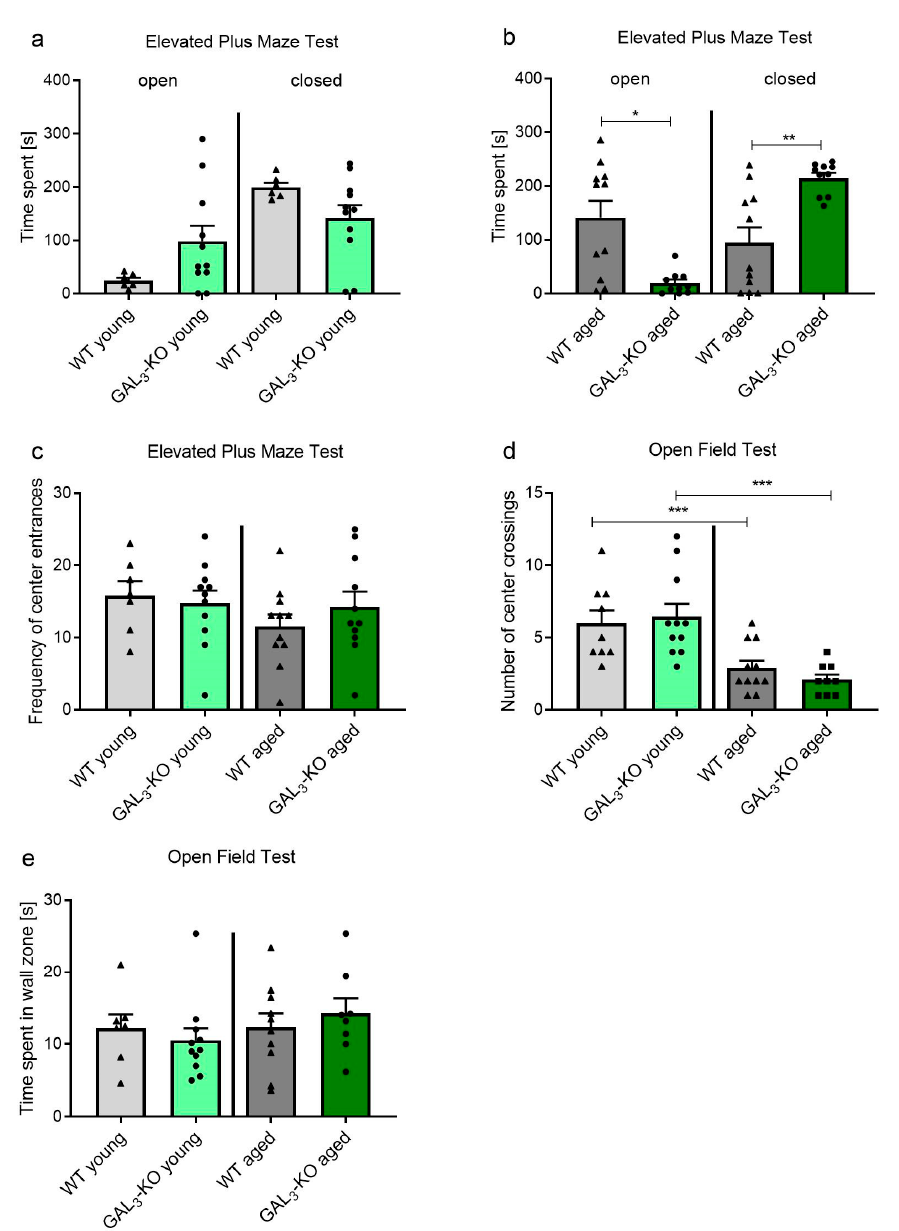
Figure 1. Behavior of GAL 3 -KOand WT mice in ( a – c ) EPM and ( d , e ) OF tests. Time spent in the open and closed arms of the EPM in ( a ) 3-month-old (young) and ( b ) 12–14-month-old (aged) mice. ( c ) Frequency of center entrances in the EPM in young and aged mice. ( d ) Number of center crossings and ( e ) time spent in the wall zone of the OF test in young and aged mice. Values are represented as mean ± SEM, n = 6–11 animals per group, * p < 0.05, ** p < 0.01, *** p < 0.001. GAL 3 -KO: GAL 3 -knockout; WT: Wildtype; EPM: Elevated Plus Maze; OF: Open Field. We extended the same analyses to GAL 2 -KO mice. In the EPM, young GAL 2 -KO mice stayed longer in the closed arms compared to their age-matched WT controls, but no dif- ferences for the open arms were detected (closed arms: 180.5 ± 31.6 s (WT, n = 11) vs. 216.7